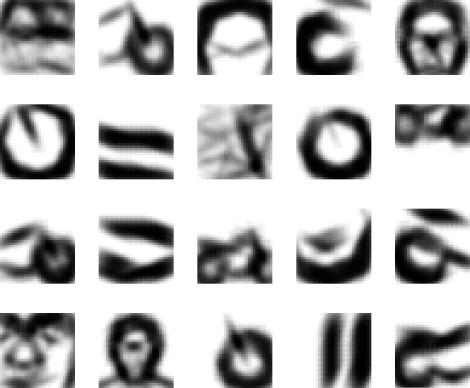
Final Reconstructions for the 20 Features in the Mixed CaseThe 20 cells self-organized, some having developed selectivity to face features, and some to motorbike features.